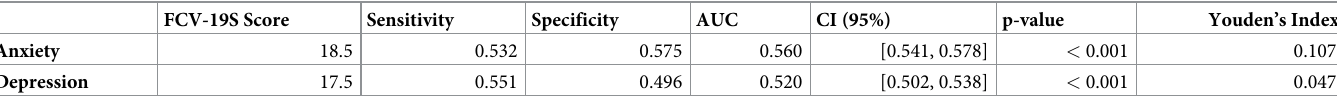
Table 5. Prediction validity of the FCV-19S.